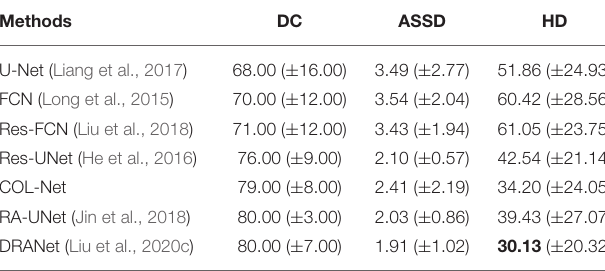
TABLE 3 | The results of the state-of-the-arts methods on the 2D SPES images.